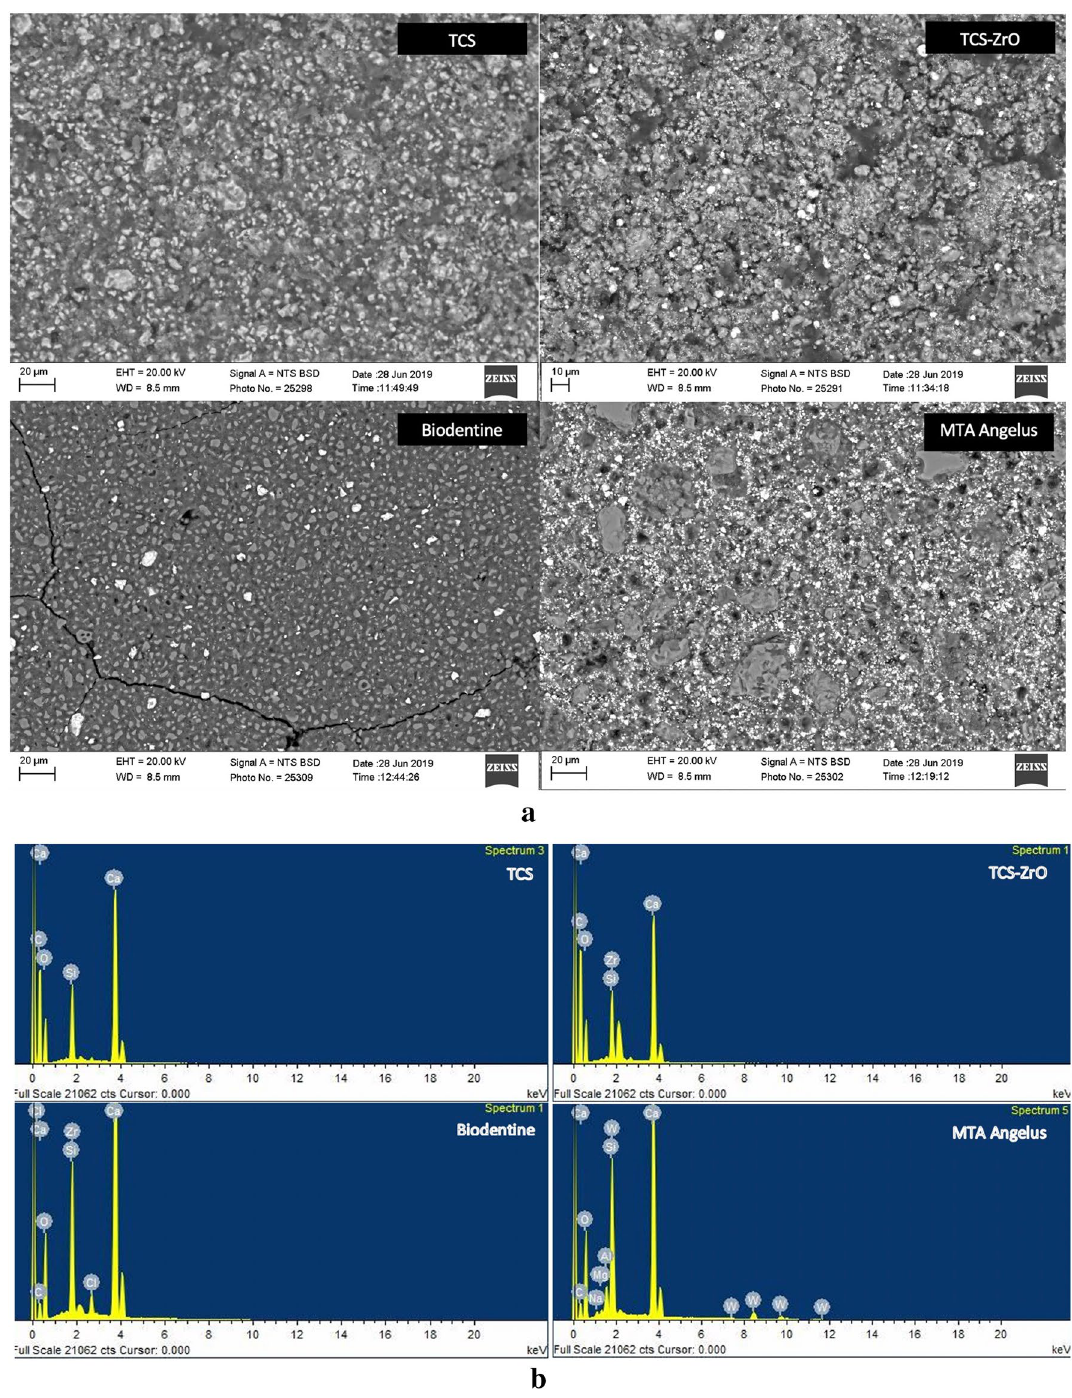
Figure 1. ( a ) Back scatter scanning electron micrographs of the test materials showing microstructural features indicating the different chemistry and microstructure (× 1 K magnification). The images show the particle sizing and radiopacifier loading with Biodentine having a smaller particle size when compared to the TCS-ZrO and MTA Angelus and less radiopacifier compared to all materials. ( b ) EDS area plots of the materials showing the elemental composition. All the materials showed peaks for calcium, silicon and oxygen. ( c ) XRD plot of the test materials showing the main phases present ( CH calcium hydroxide, CT calcium tungstate, TCS tricalcium silicate, ZO zirconium